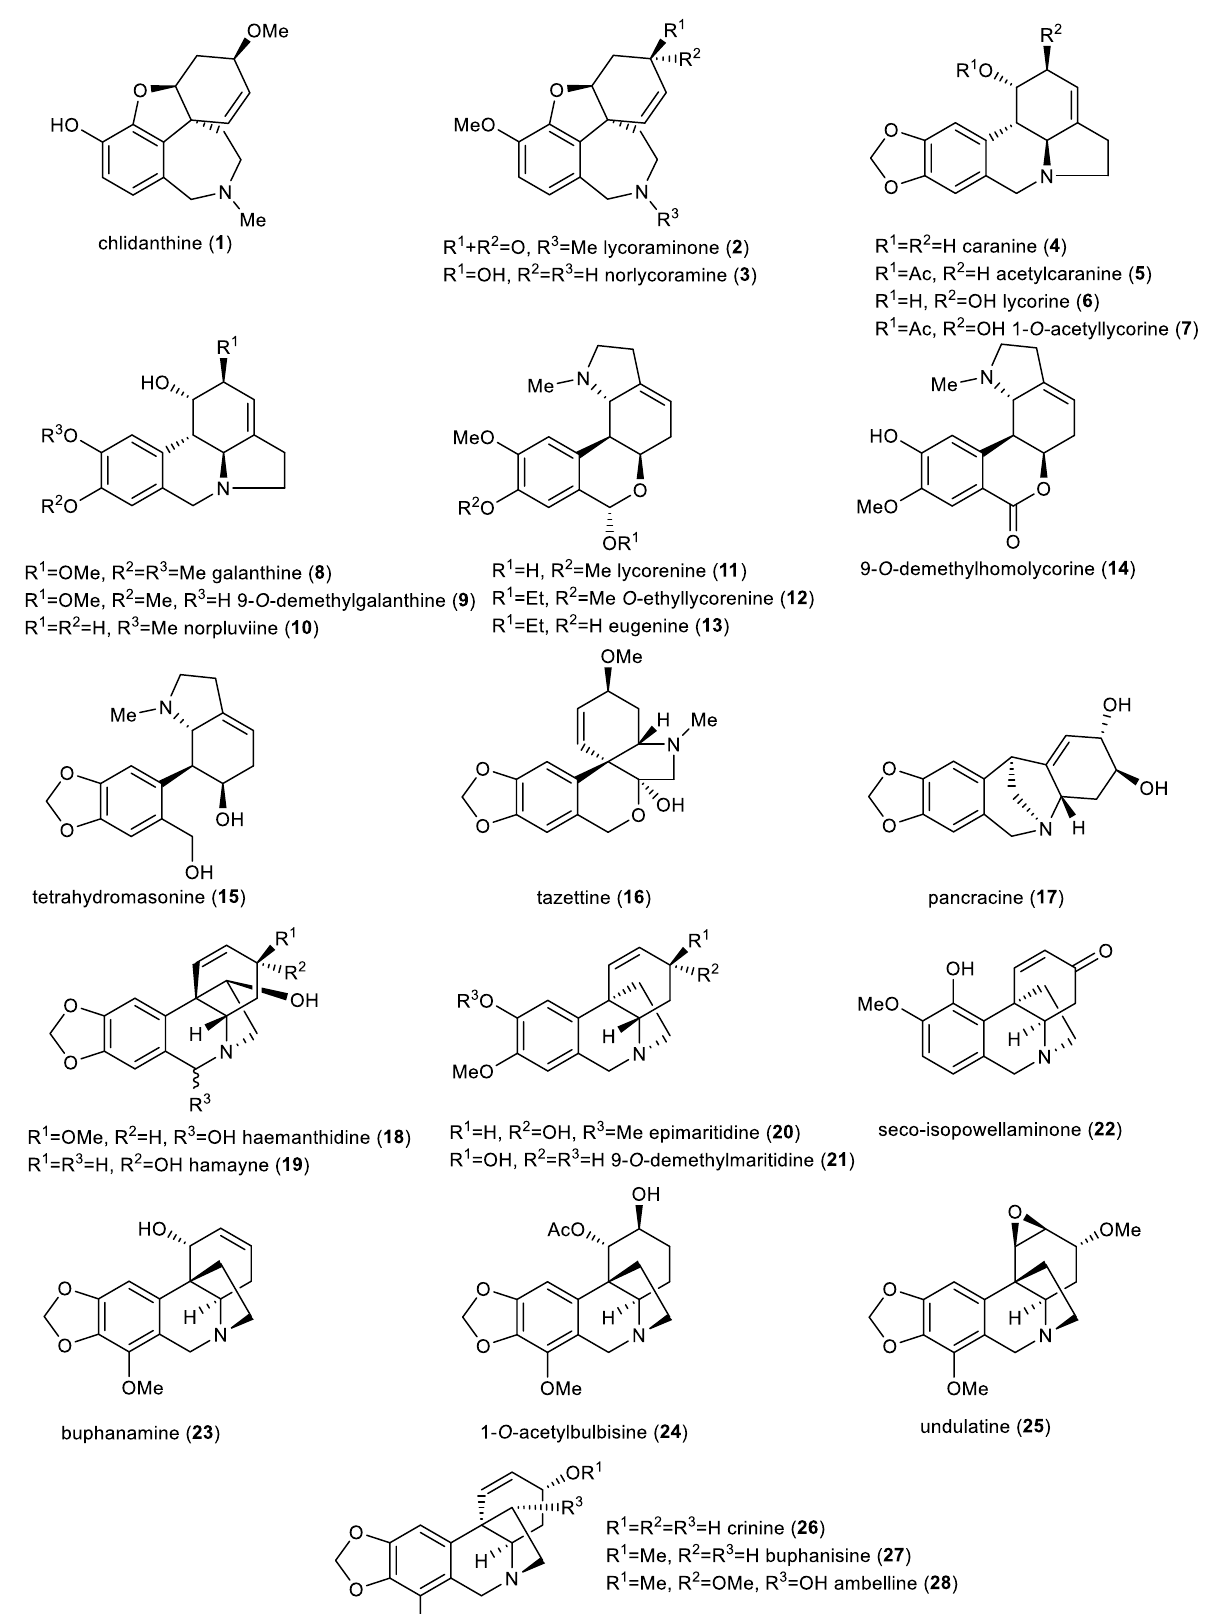
Figure 1 . Amaryllidaceae alkaloids tested against the hepatic stage of Plasmodium berghei infection in vitro.